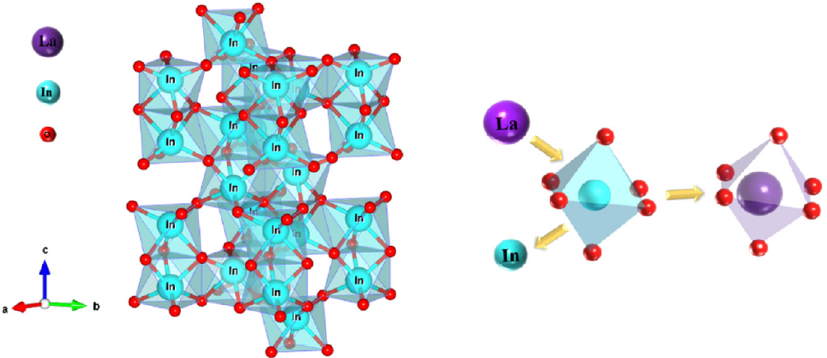
3+ replaces In 3+ 2 O 3 and La